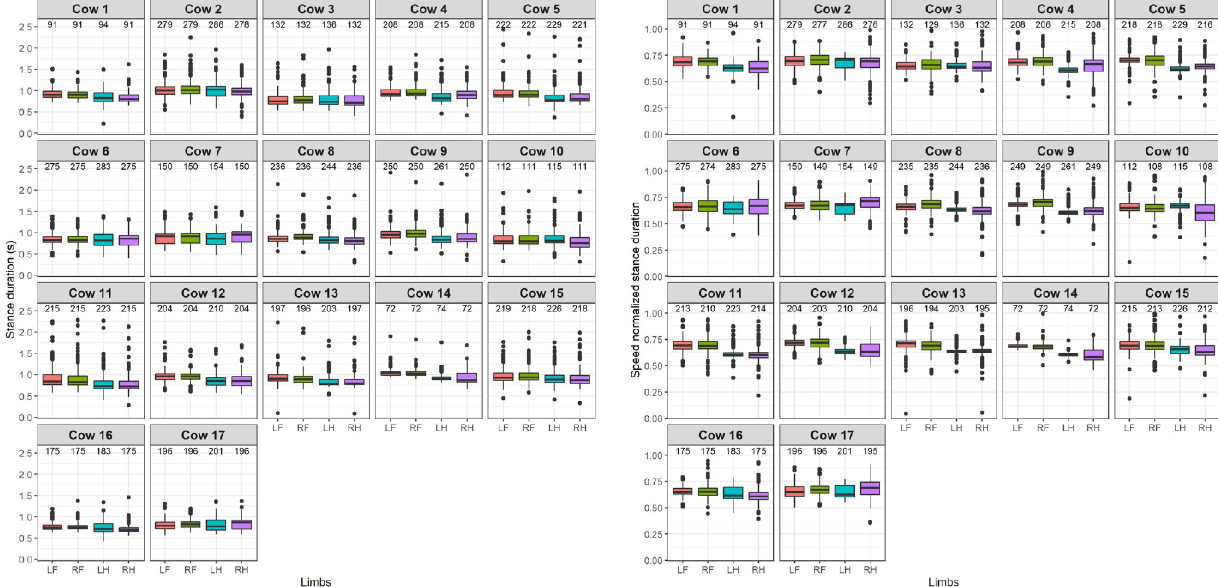
Fig 3. Distributions of stance durations (left panel) and speed normalized stance durations (right panel) for every cow and limb separately. In red: LF, green: RF, blue: LH and purple: RH. The number of selected strides per limb is shown above the boxes. The spacing of the boxplot shows the range between the first and third quartile, the median is indicated with the black line, the whiskers show the range of the maxima and minima and the outliers are indicated with dots.